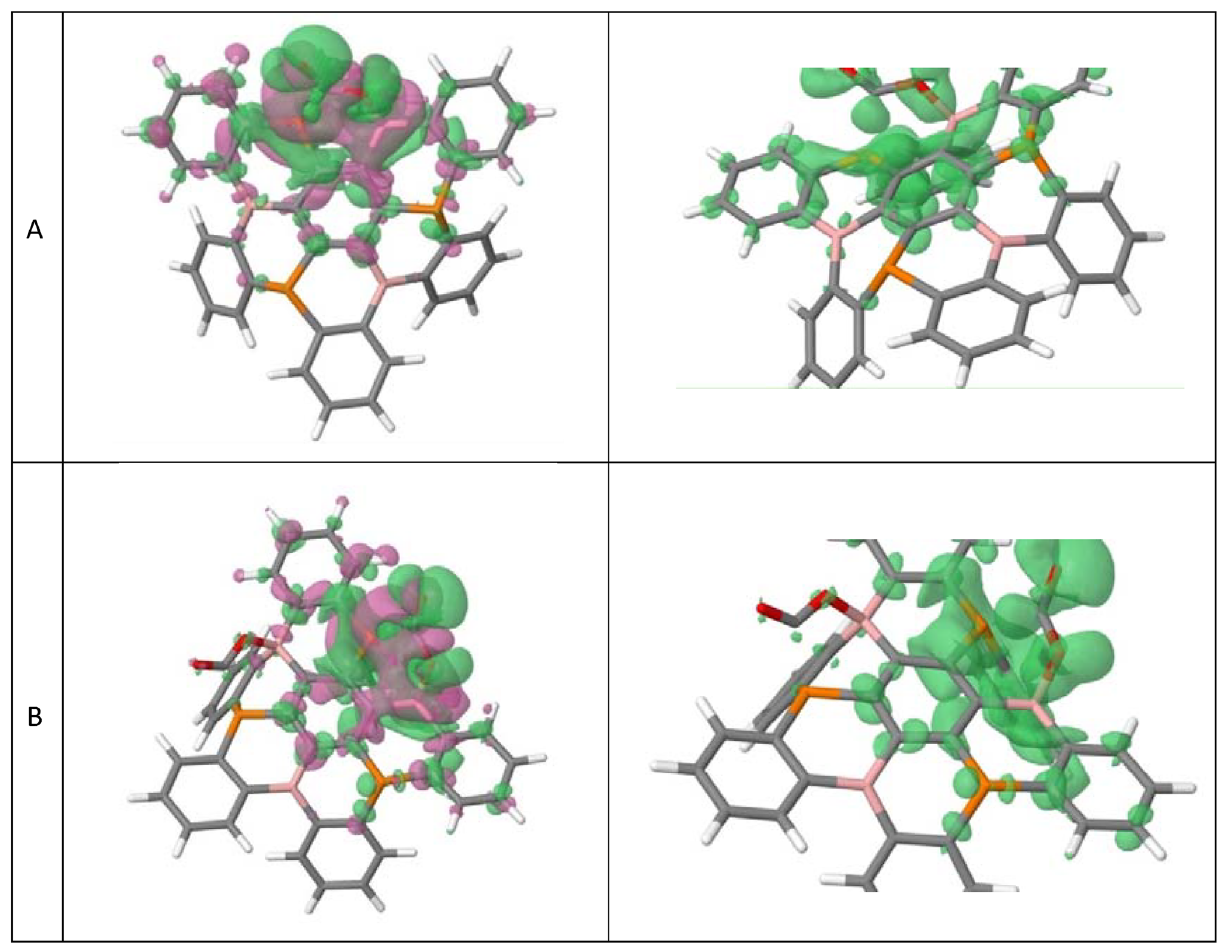
Figure 7. Electron Density Shift (EDS) plots of ( A ) 1CO 2 -(B 3 P 3 -NG) and ( B ) 2CO 2 -(B 3 P 3 -NG) . In magenta color the region of electron density decrease and in green the region of electron density increase. An isovalue of 0.001 a.u. was used for the